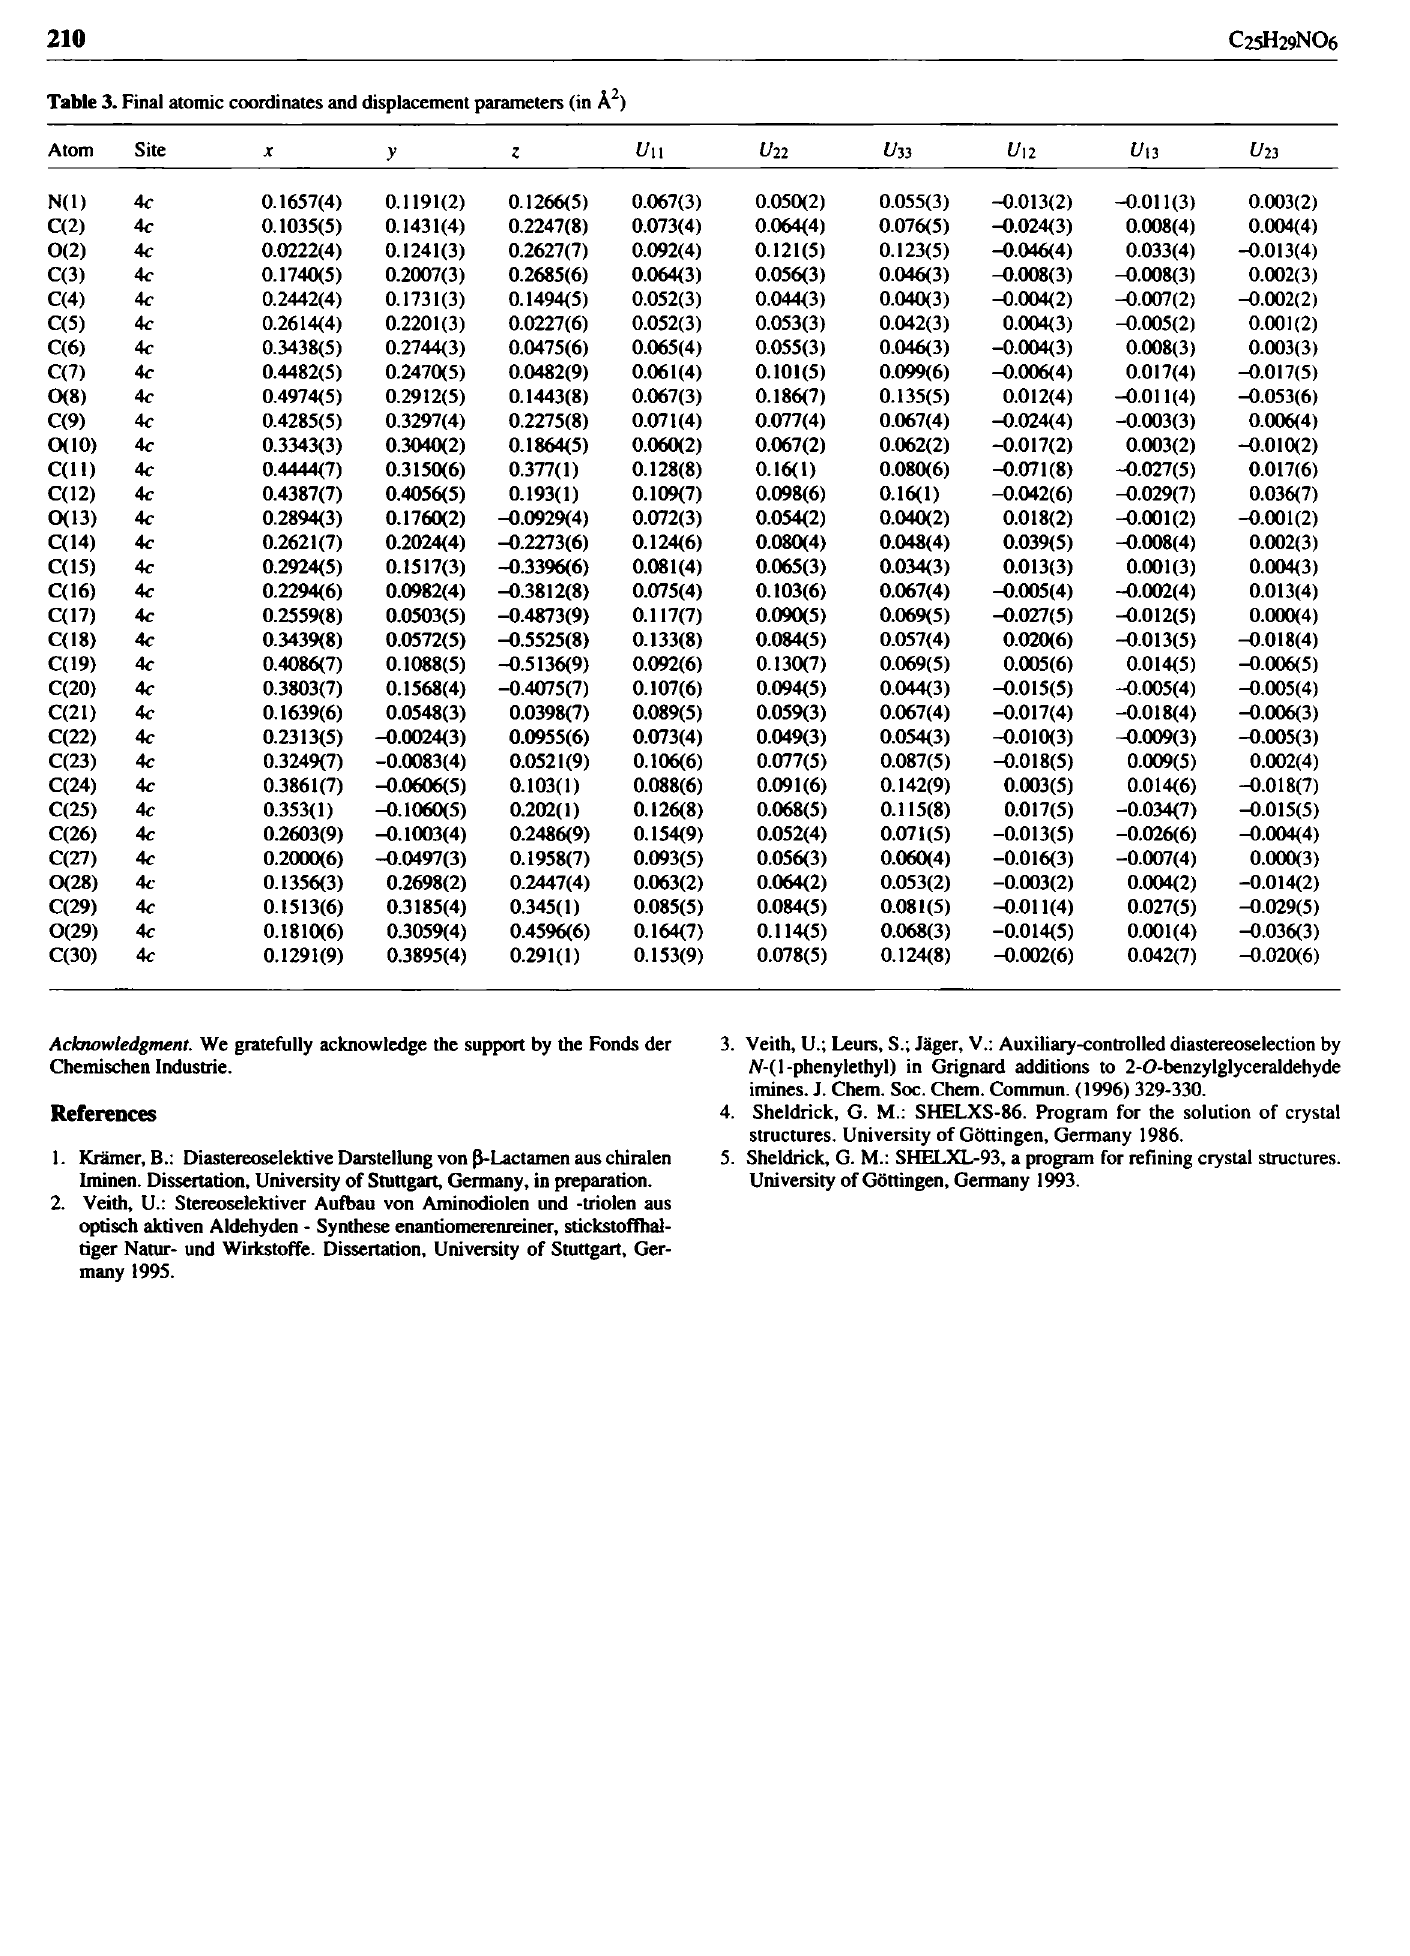
Table 3. Final atomic coordinates and displacement parameters (in Â 2